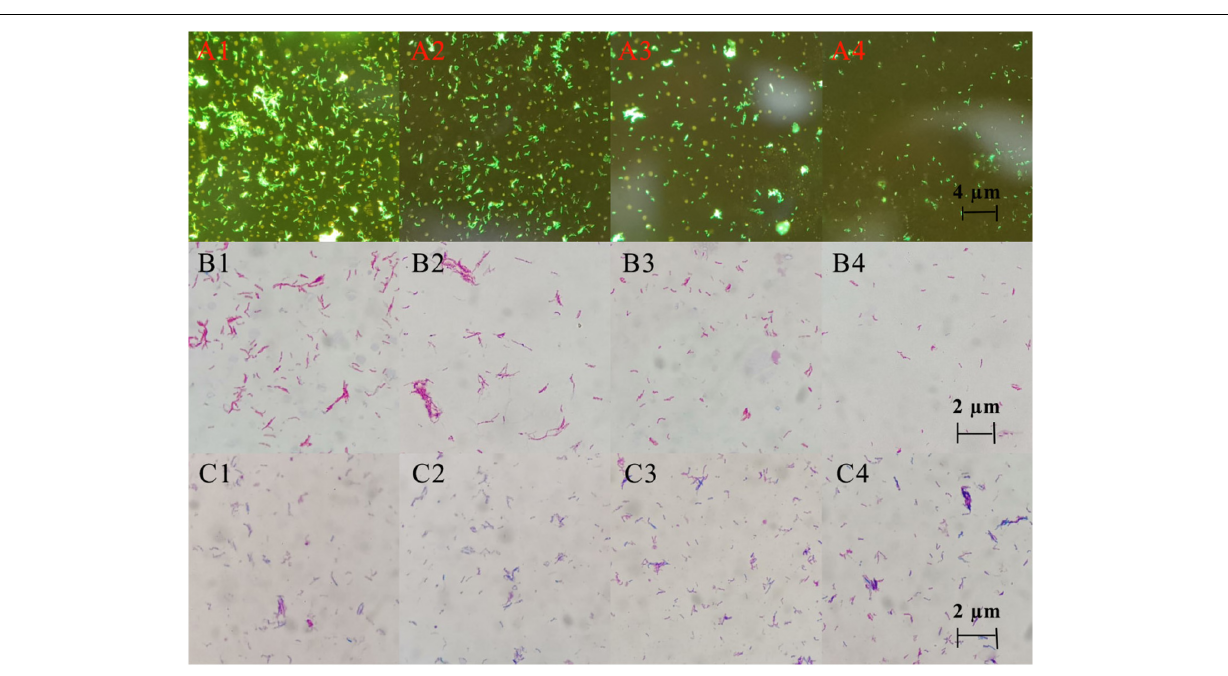
FIGURE 5 | Auramine “O” staining, acid-fast staining, and gram staining pictures of MTB after 6 days treatment with 8.0 µ g/ml DHA-CS NPs ( n = 3). (A1–4) auramine “O” staining, (B1–4) acid-fast staining, (C1–4) Gram staining, (A1,B1,C1) Negative control group, (A2,B2,C2) DHA drug group, (A3,B3,C3) 8.0 µ g/ml CS NPs drug group, (A4,B4,C4) 8.0 µ g/ml DHA-CS NPs drug